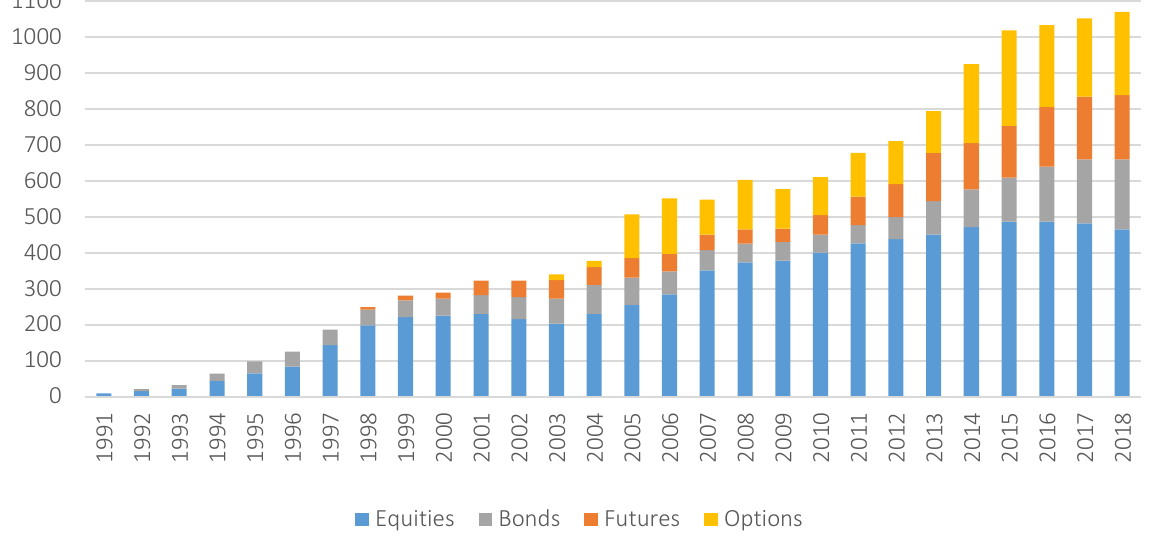
Table 2. Selected macroeconomic indicators of the Polish economy